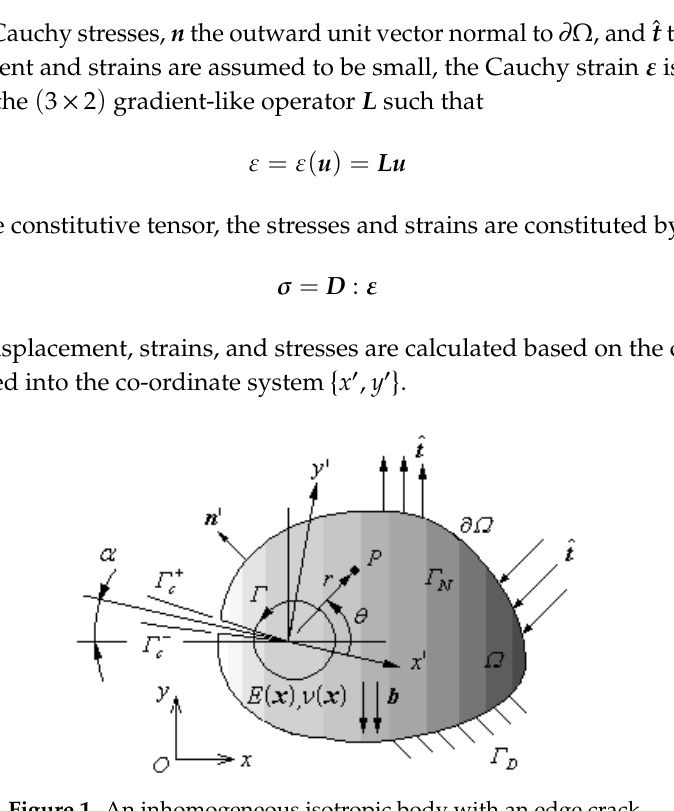
Figure 1. An inhomogeneous isotropic body with an edge crack.